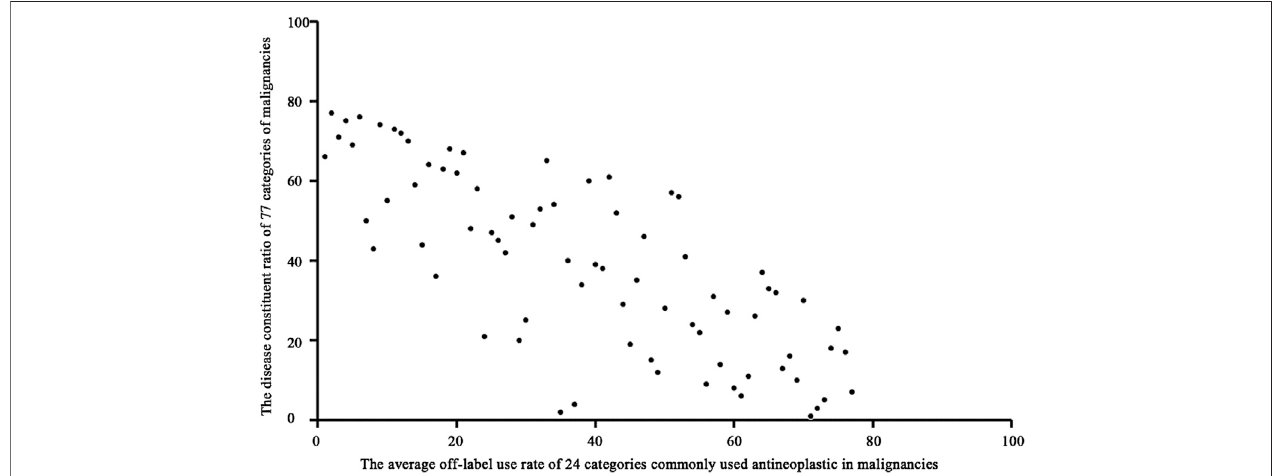
FIGURE 3 | Scatter diagram of the average OL use rate of antineoplastic drugs used to treat malignancies.